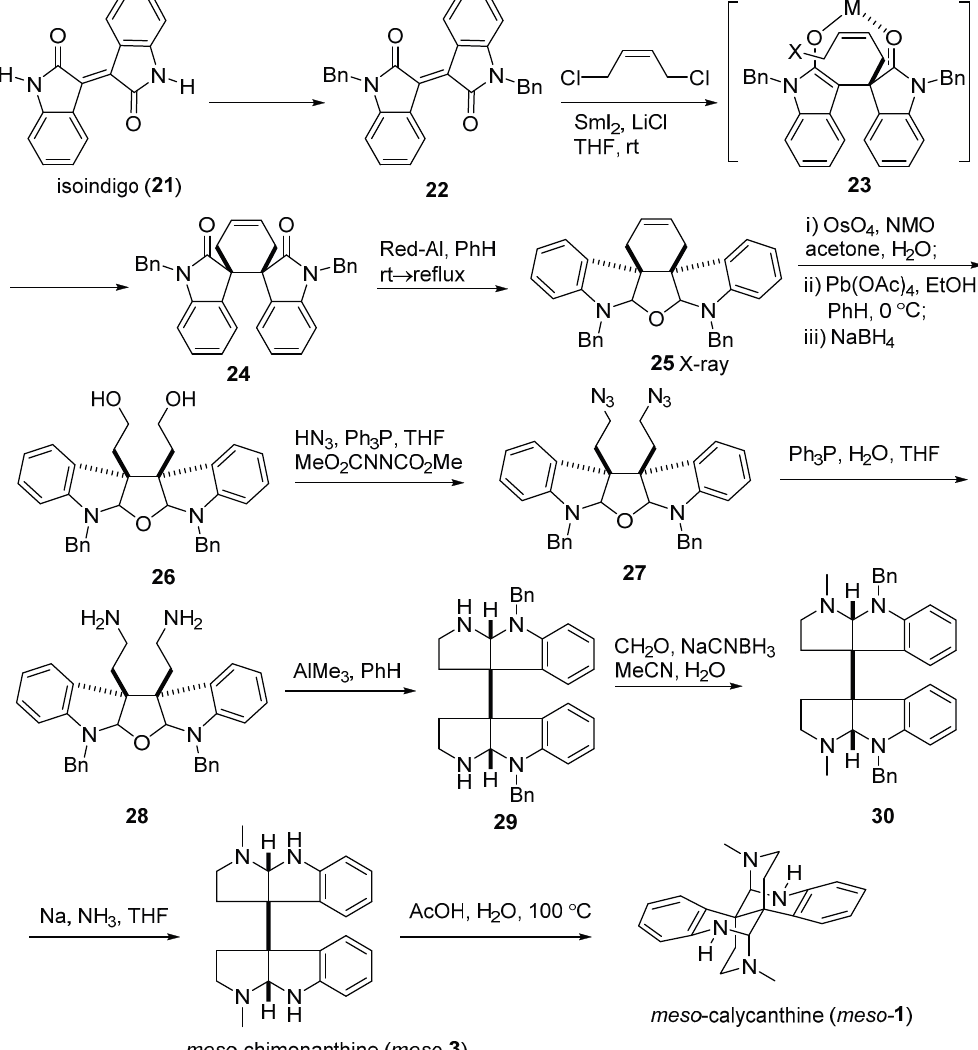
Scheme 4. Stereocontrolled syntheses of meso -chimonanthine and meso -calycanthine by